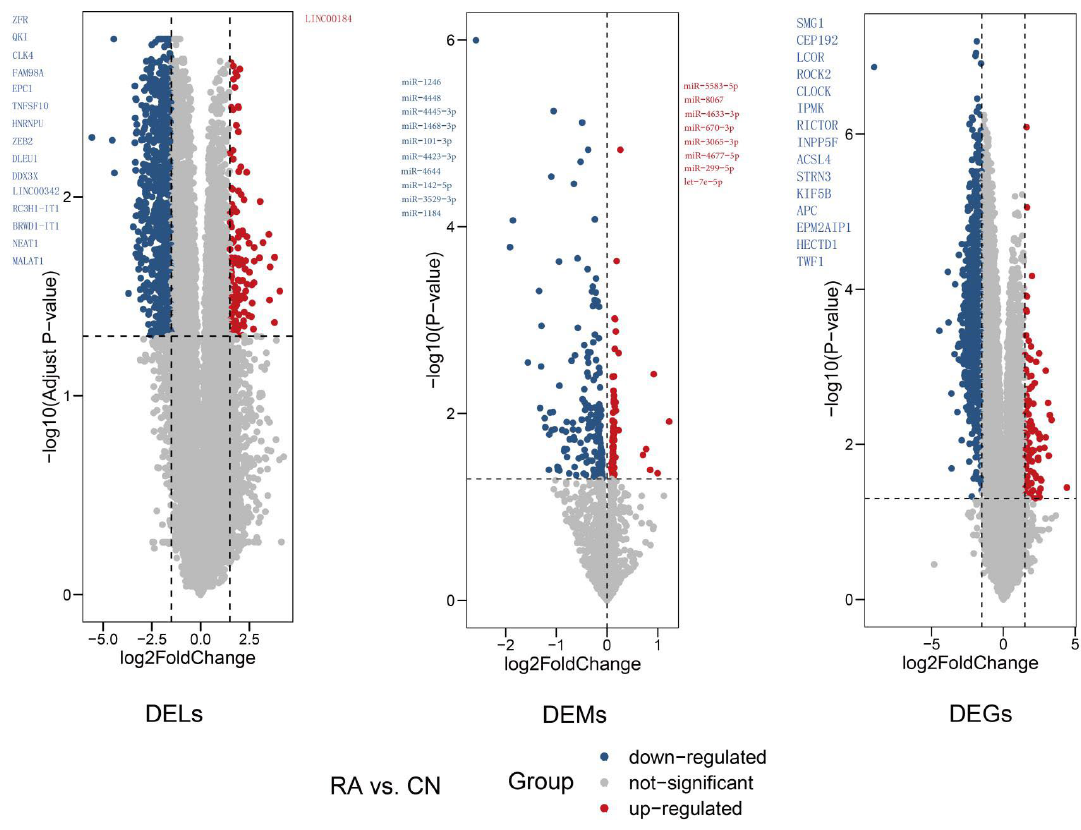
Figure 2. DELs/DEMs/DEGs screening.